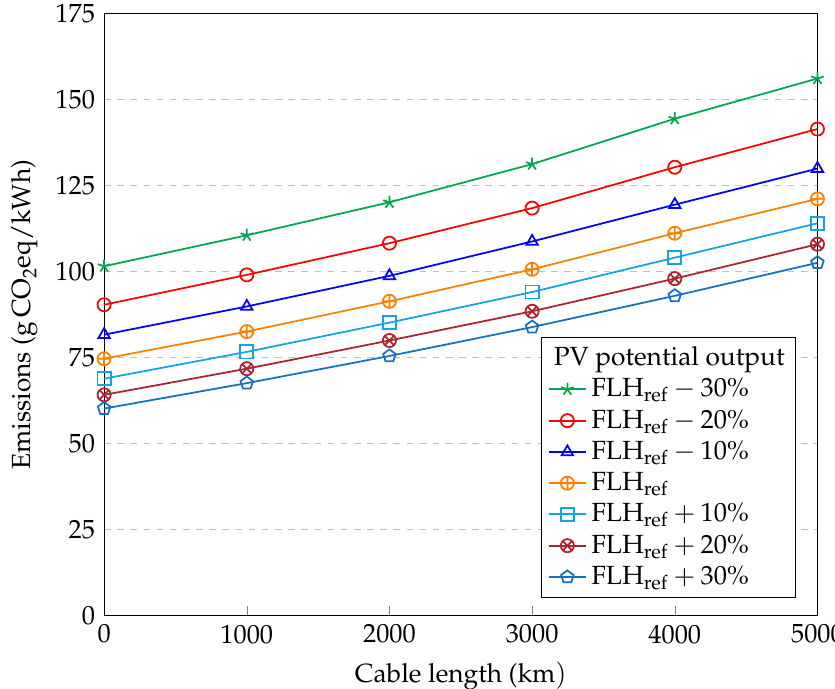
Figure 5. Emissions per kWh of electricity generated for different numbers of full-load hours and different cable lengths.